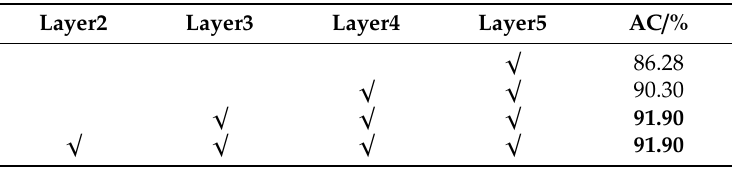
Table 4. Combining features from di ff erent